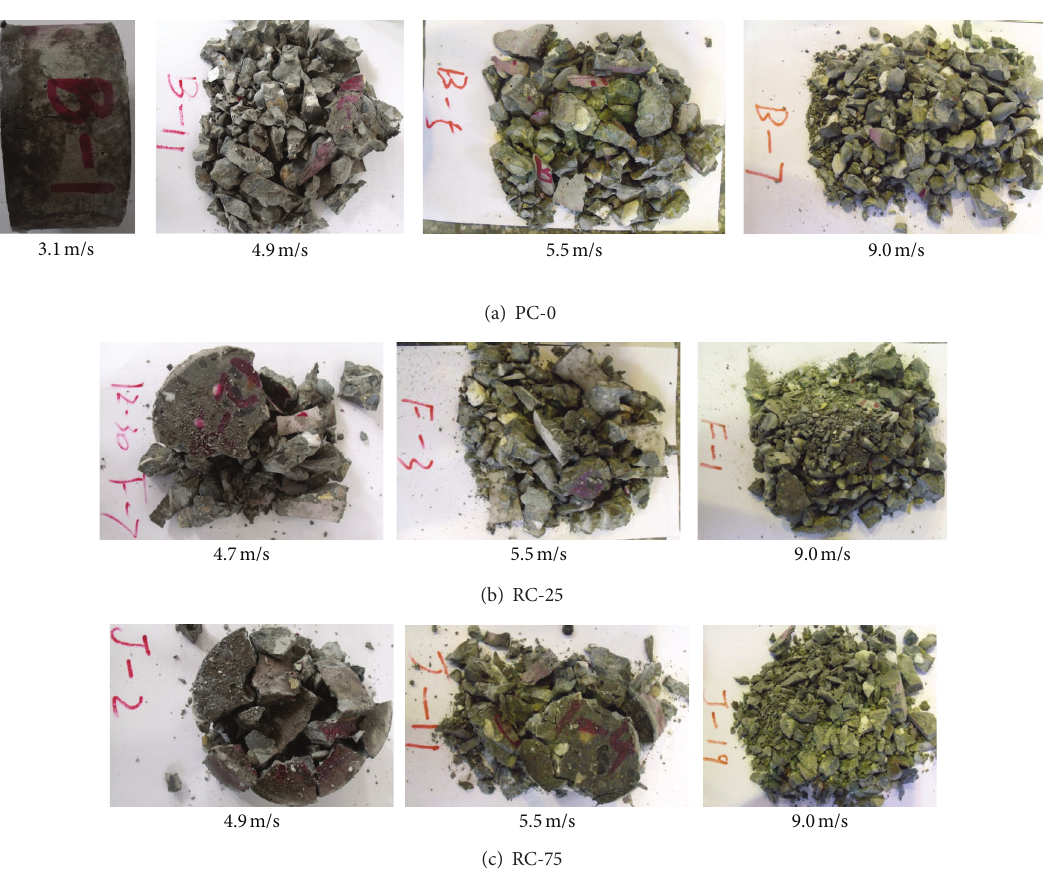
Figure 7: Failure patterns of RAC specimens under various striking velocities.